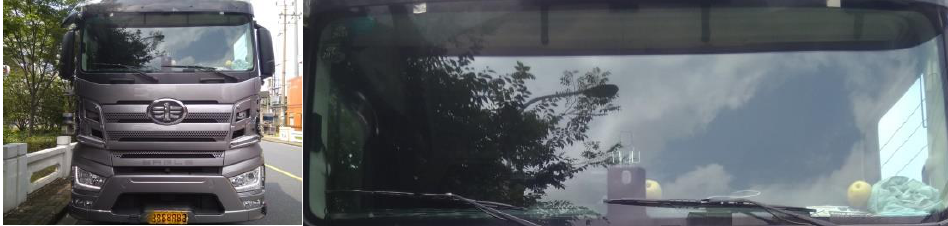
Figure 5. The front-facing mono camera.